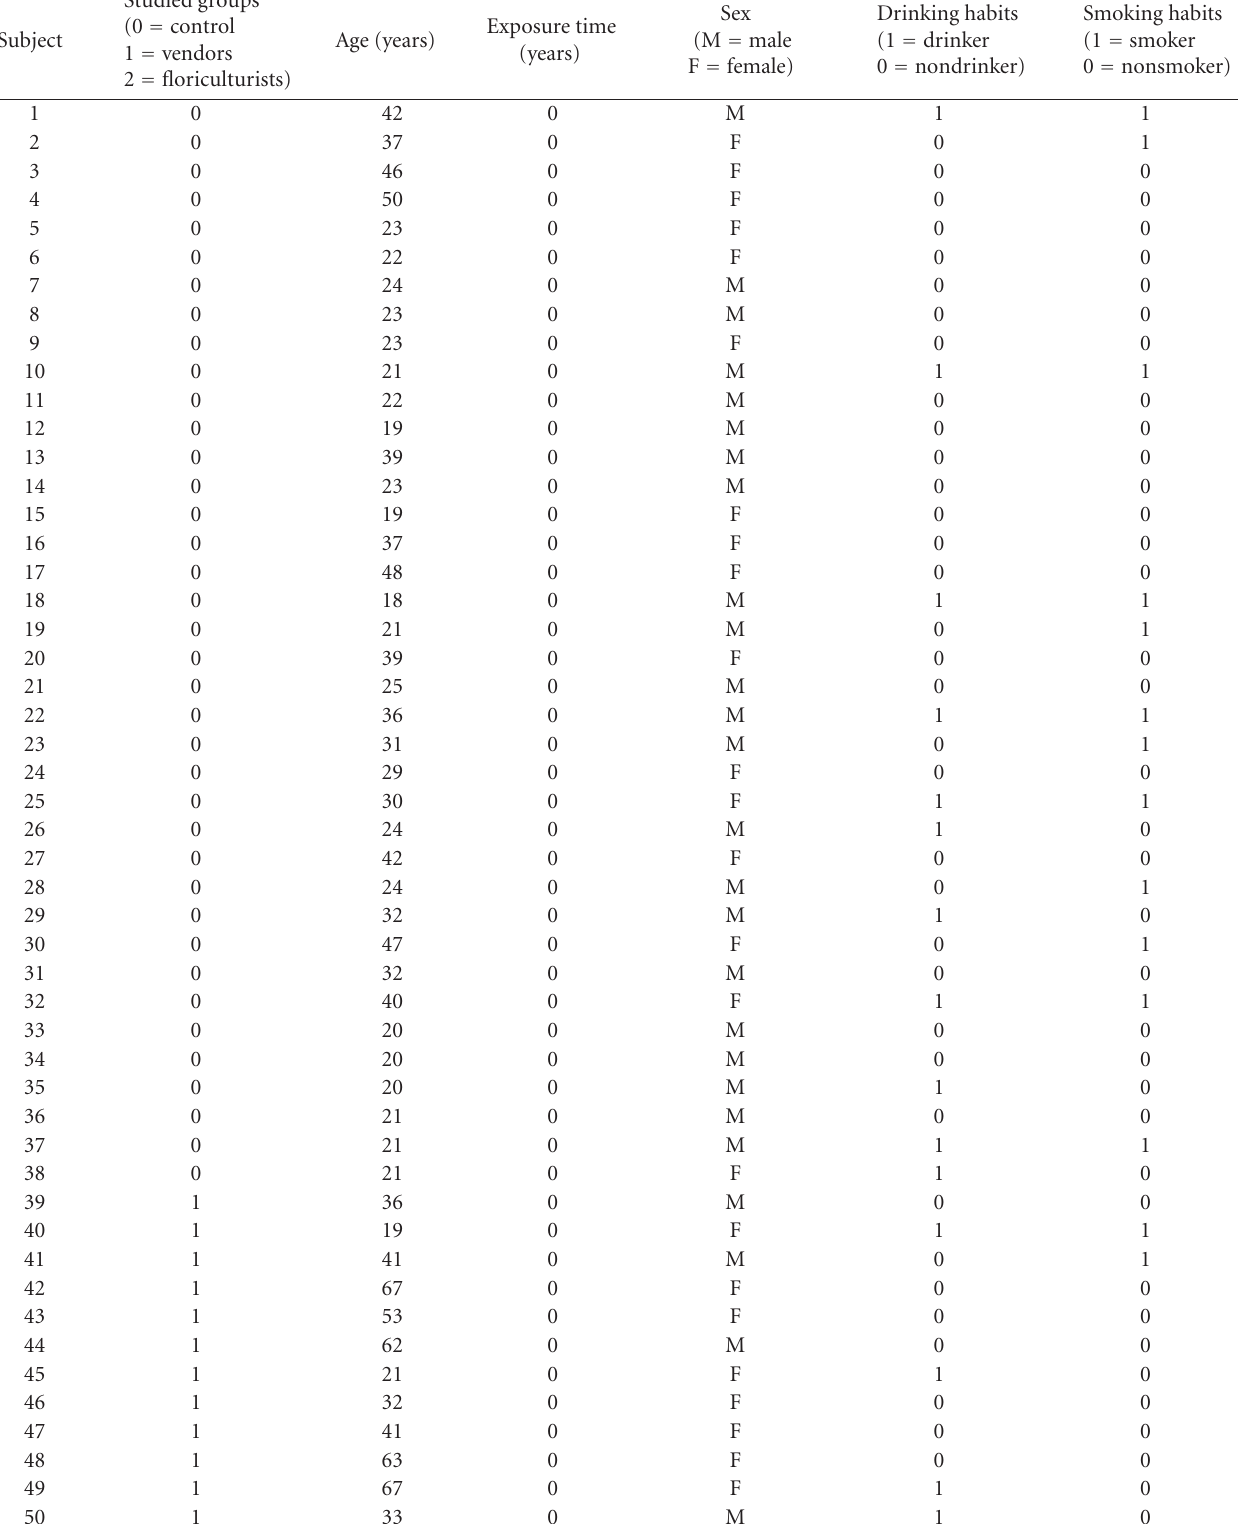
Table 1: Individual characteristics of the study